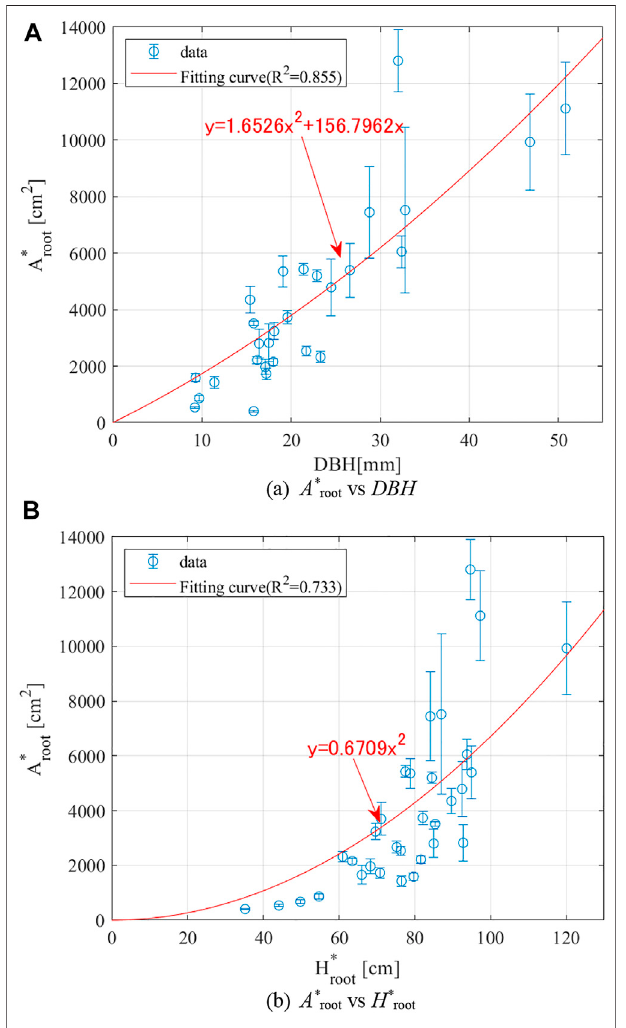
FIGURE 4 | Relationships of the projected areas of the root system A p root with DBH and the height of the root system H p root (circle: measured data, solid line: regression curve) ( Rhizophora stylosa ). Note that the error bars indicate the variation of frontal areas taken from different orientations (See Methodology ).